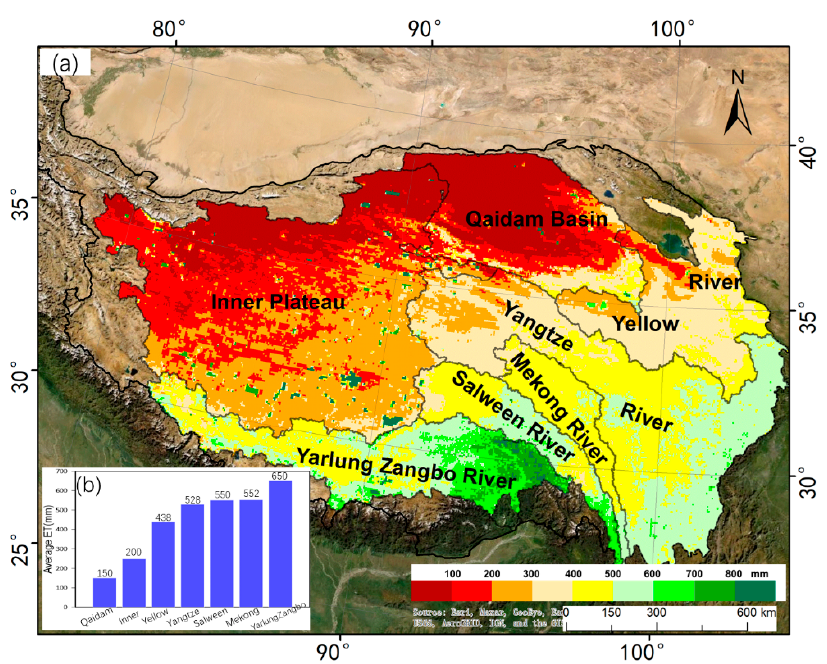
Figure 9. Distribution of average corrected ET in the sub-basins on the Tibetan Plateau. ( a ) The spatial distribution of average corrected ET, ( b ) The statistics of average corrected ET in each sub-basin.